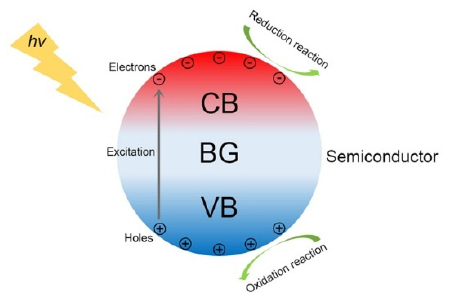
Figure 1. Schematic diagram for the photocatalytic process.